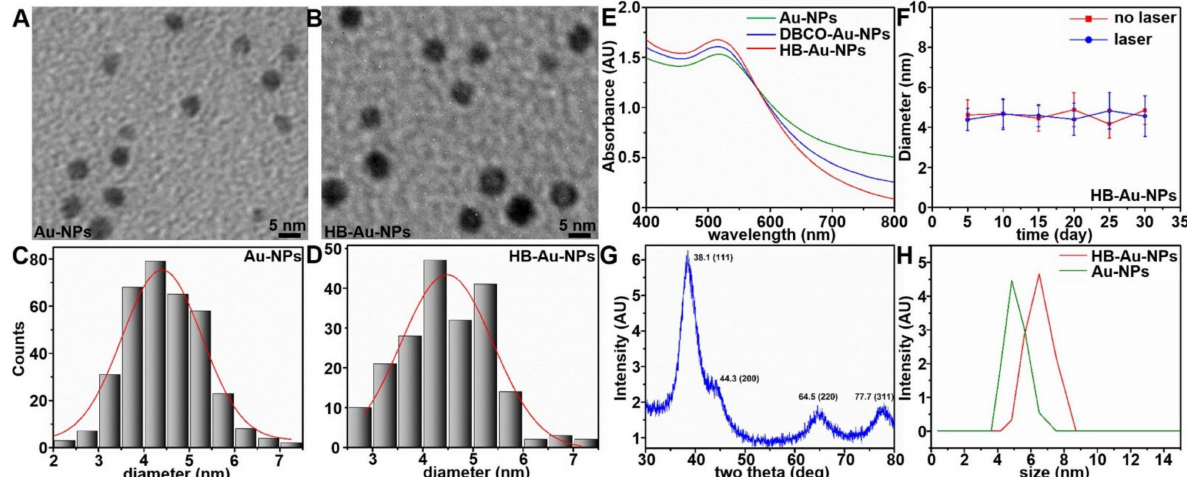
Figure 2. Nanoparticle characterization. TEM images of ( A ) Au-NPs and ( B ) HB-Au-NPs show spherical morphology. ( C, D ) A mean ( ± SD) diameter of 4.24 ± 0.83 and 4.47 ± 0.88 nm, was measured for Au-NPs and HB-Au-NPs, respectively. ( E ) The absorbance spectra for Au-NPs, DBCO-Au-NPs, and HB-Au-NPs show no shift in the peak at 518 nm. ( F ) No change is seen in the mean ( ± SD) diameter of HB-Au-NPs in PBS as a function of storage time over 30 days at RT with and without 5 min of laser irradiation (100 µ J/cm 2 ). Error bars represent standard deviations of n = 3 independent measurements. ( G ) The XRD pattern shows crystalline nanoparticles represented by 4 peaks corresponding to the standard Bragg reflections (111), (200), (220), and (311) of the center faces in a cubic lattice. The peak at 38.1 deg represents preferential growth in the (111) direction. ( H ) Dynamic light scattering (DLS) measurements show mean ( ± SD) diameter of 6.41 ± 0.73 and 5.50 ± 0.63 nm, respectively, for HB-Au-NPs and